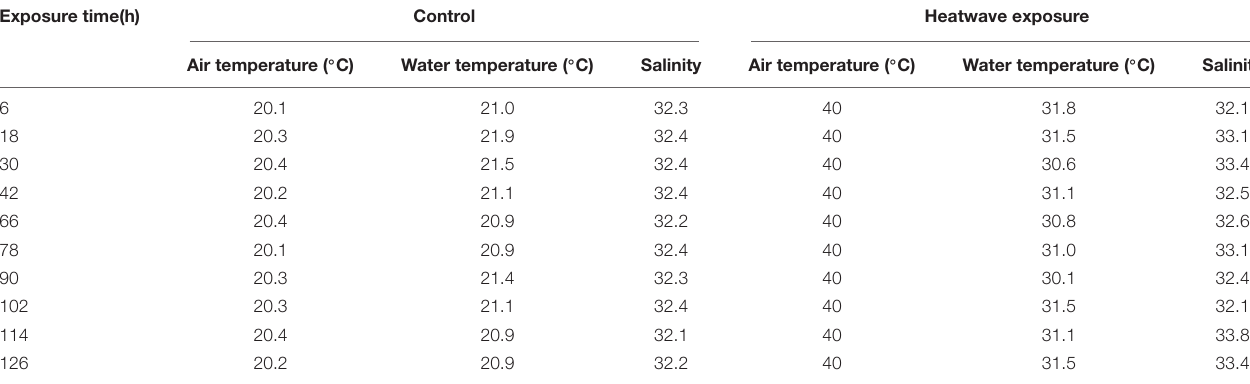
TABLE 1 | Air and seawater temperature and salinity of the experimental conditions were determined at each sampling time. Exposure